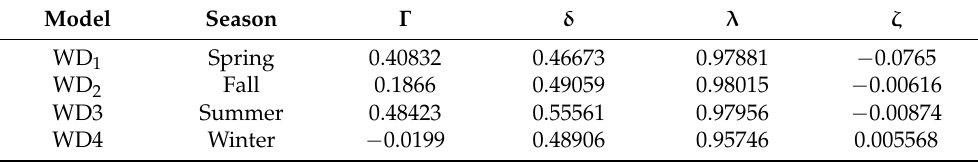
Table 4. Johnson SB PDF parameters for different wind DG models